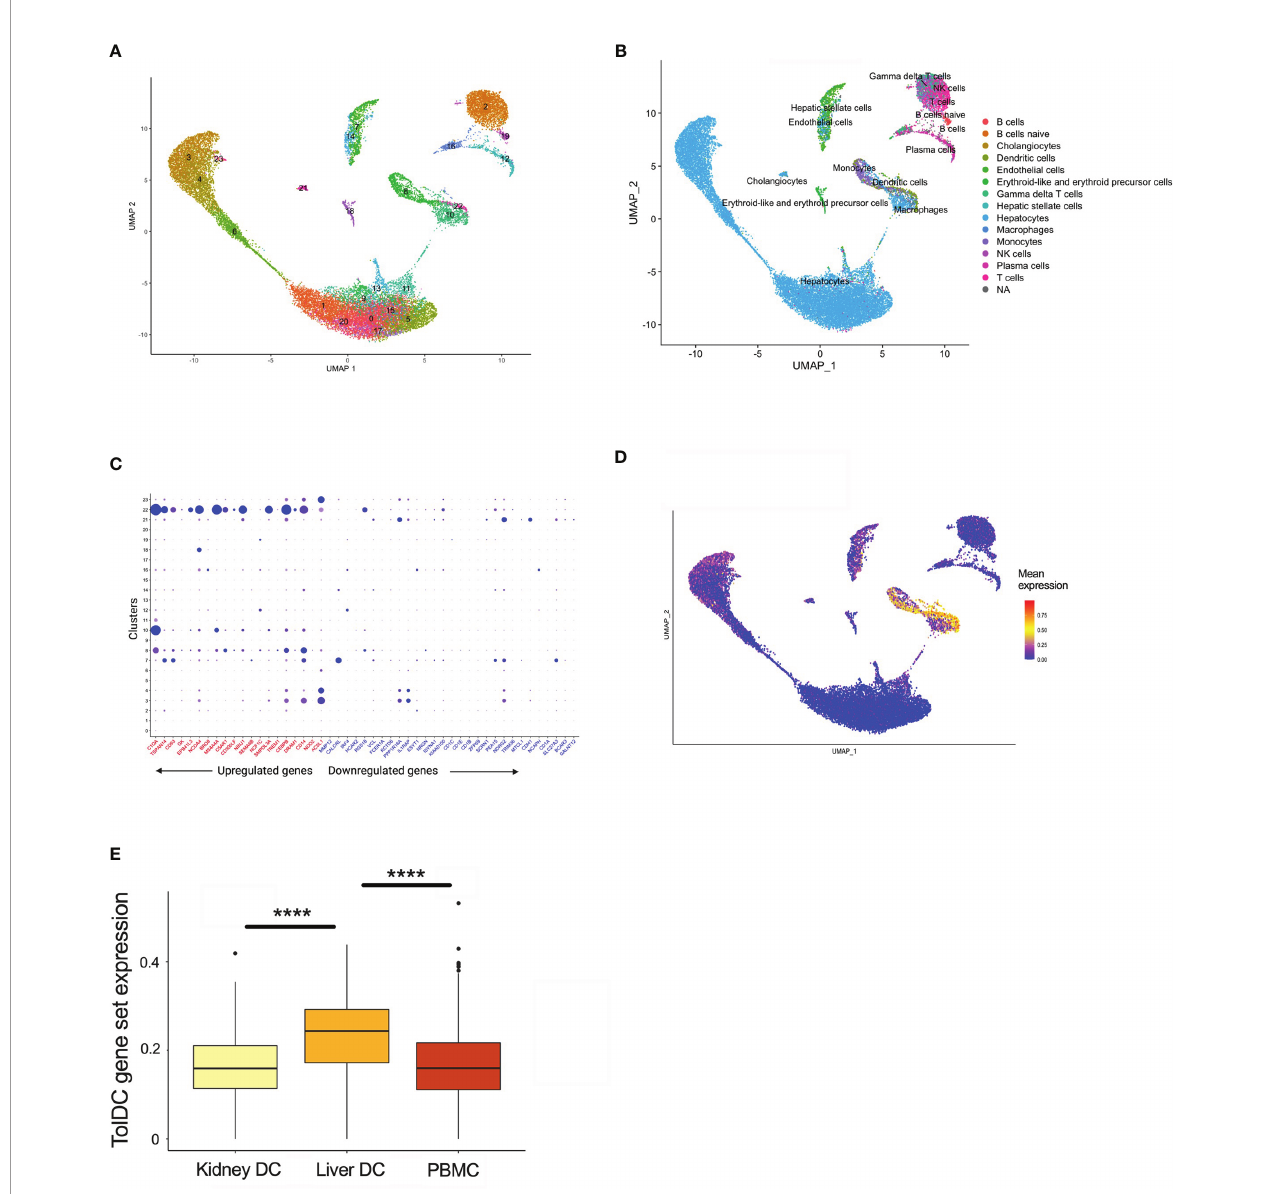
FIGURE 5 | TolDC gene set is overexpressed in liver-resident DC. (A) UMAP plot displaying the clustering of harmony integrated scRNAseq samples. (B) UMAP plot of liver datasets annotated by cell type. (C) Dot plot displaying up- and down-regulated tolDC gene expression markers enriched within cell clusters. (D) UMAP plot demonstrating a joint density analysis of upregulated genes from the tolDC gene set. (E) Boxplot displaying the expression of the tolDC gene set across tissue- resident and circulating DC. ****p <